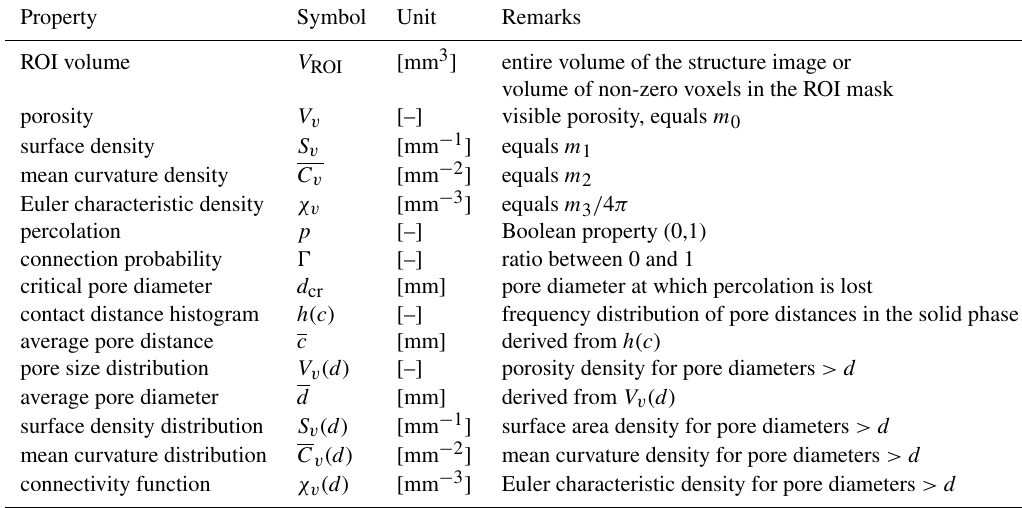
Table 2. Summary of image analysis results. Property Symbol